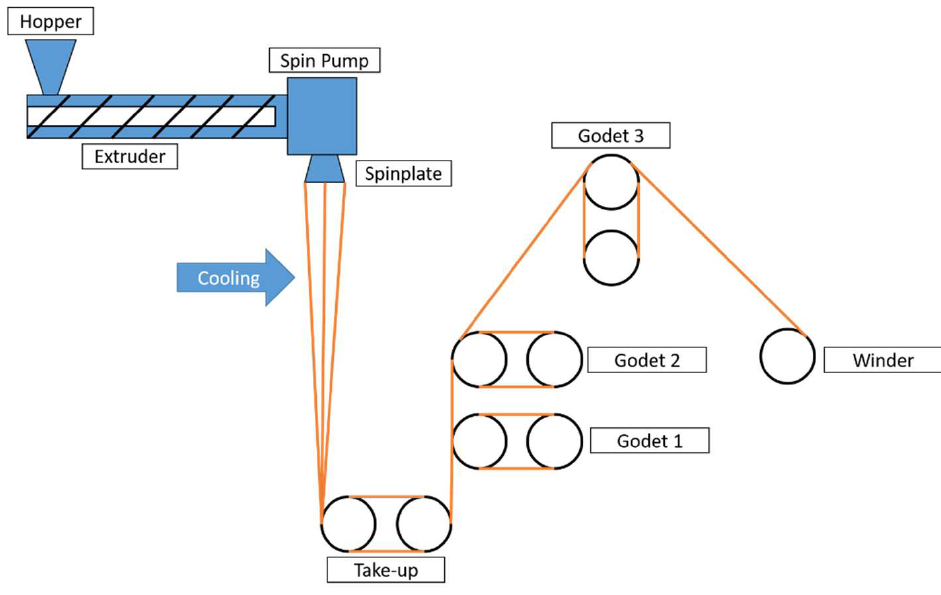
Figure 1. The spinning line of the FET-100 device.